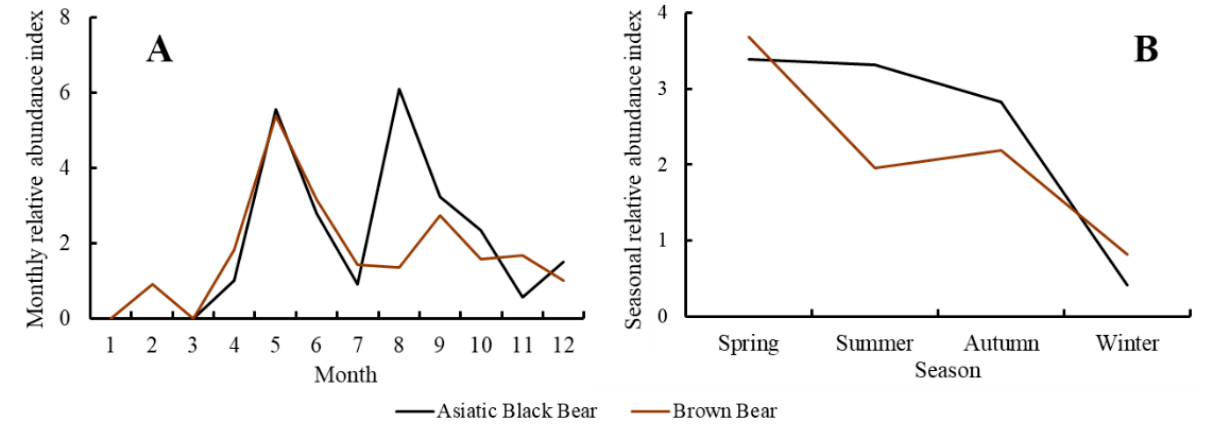
Figure 2. Monthly ( A ) and seasonal ( B ) activity patterns of Asiatic black bear and brown bear in Taipinggou National Nature Reserve, Heilongjiang Province, China, 2017.